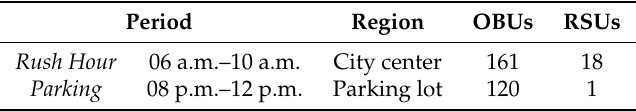
Table 1. Characteristics of the dataset for each evaluated